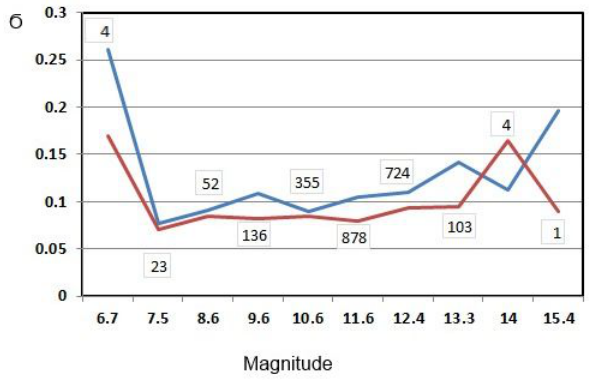
Figure 5. Root mean square errors the equatorial coordinates (RA – Blue line, DEC – red line) for different intervals of B(T). Number of stars in the interval is given by